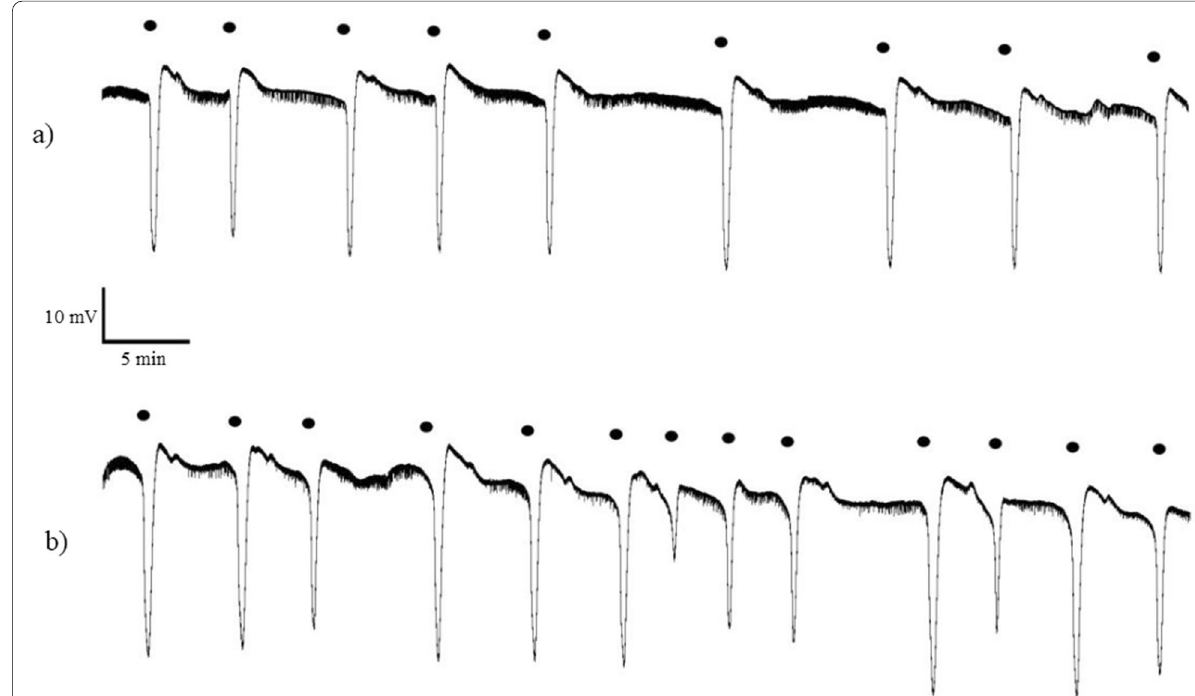
Fig. 4 Representative intracortical microelectrode recordings provided from chronic mefenamic acid admistrated rats followed by a ) a single dose of DMSO or b ) a single dose of hesperidin on day 28